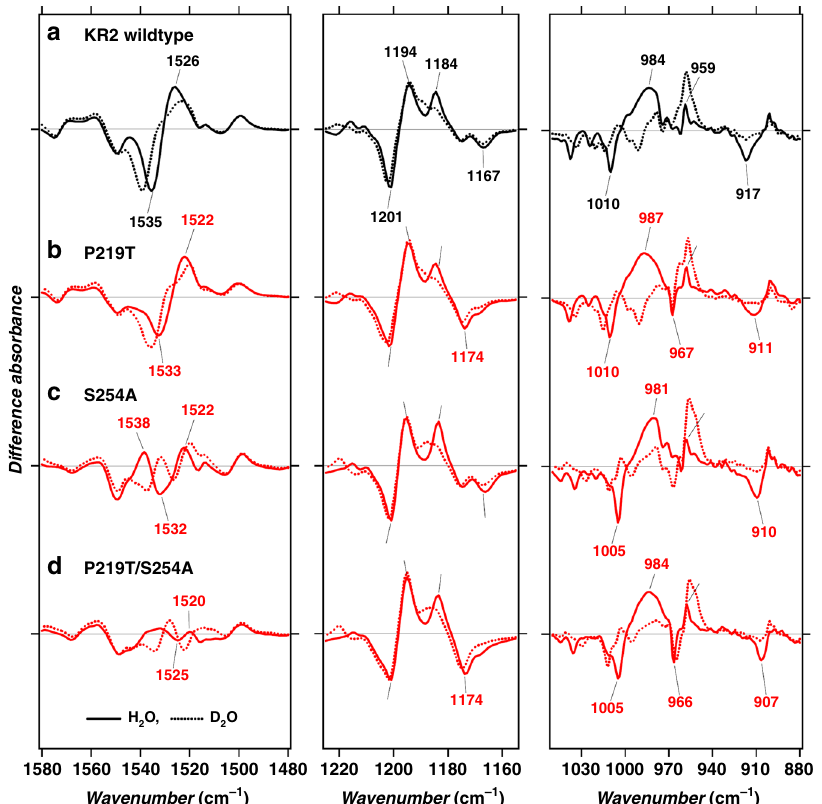
Fig. 4 Light-induced infrared absorption changes of the KR2 mutants. Light-induced Fourier transform infrared difference spectra of a KR2 wildtype (black) and the mutants (red), b P219T, c S254A and d P219T/S254A, in the 1580 – 1480 (left), 1225 – 1155 (middle) and 1050 – 880 cm − 1 (right) regions at T = 77 K and pH 8.0. Solid and dotted lines represent the samples hydrated with H 2 O and D 2 O, respectively. Source data are provided as a Source Data fi